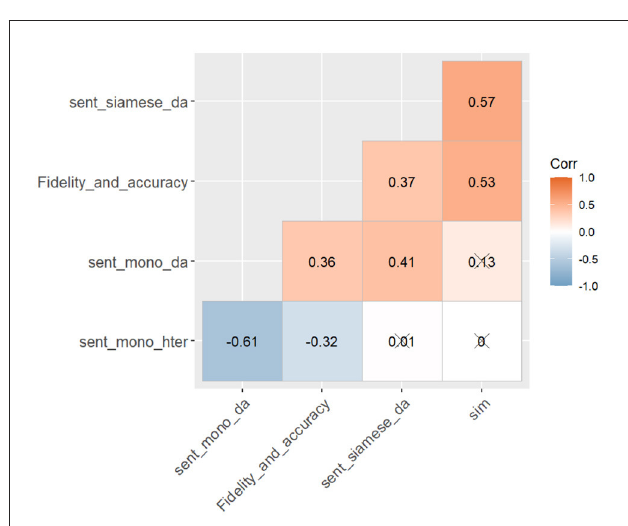
FIGURE4 Correlation matrix chart among scores computed by neural networks and human assessment for